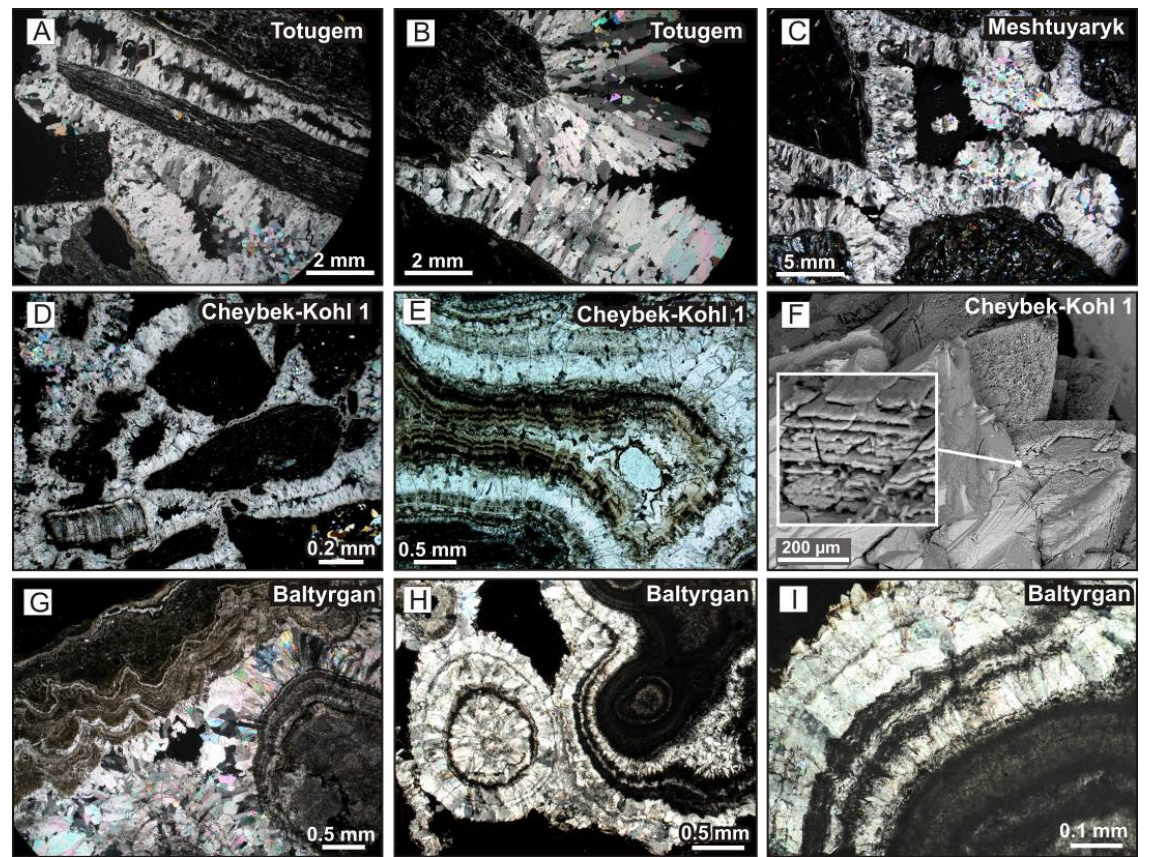
Figure 12. Photomicrographs of the fossil travertine samples composed of calcite. ( A–D ) Closely packed druse aggregates of elongate calcite crystals covering angular detrital clasts. ( E,G–I ) Calcite- laminated crusts composed of translucent sparite layers alternating with brown micrite laminae enriched in detrital material. ( F ) Calcite crystals with evidence of repeated surface etching and regeneration. Cross-polarized light ( A–D,G ), plane-polarized light ( E,H,I ), and backscattered electron (BSE) images ( F ).